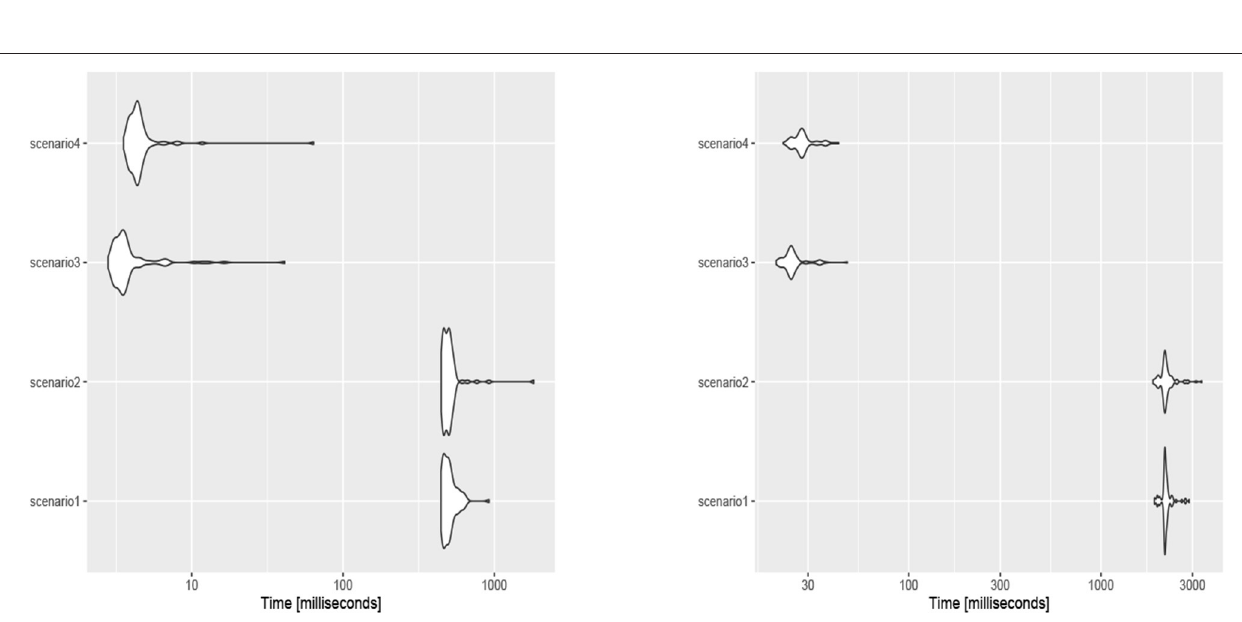
10 (left) and n 50 (right) from the posterior density functions of each scenario. = =